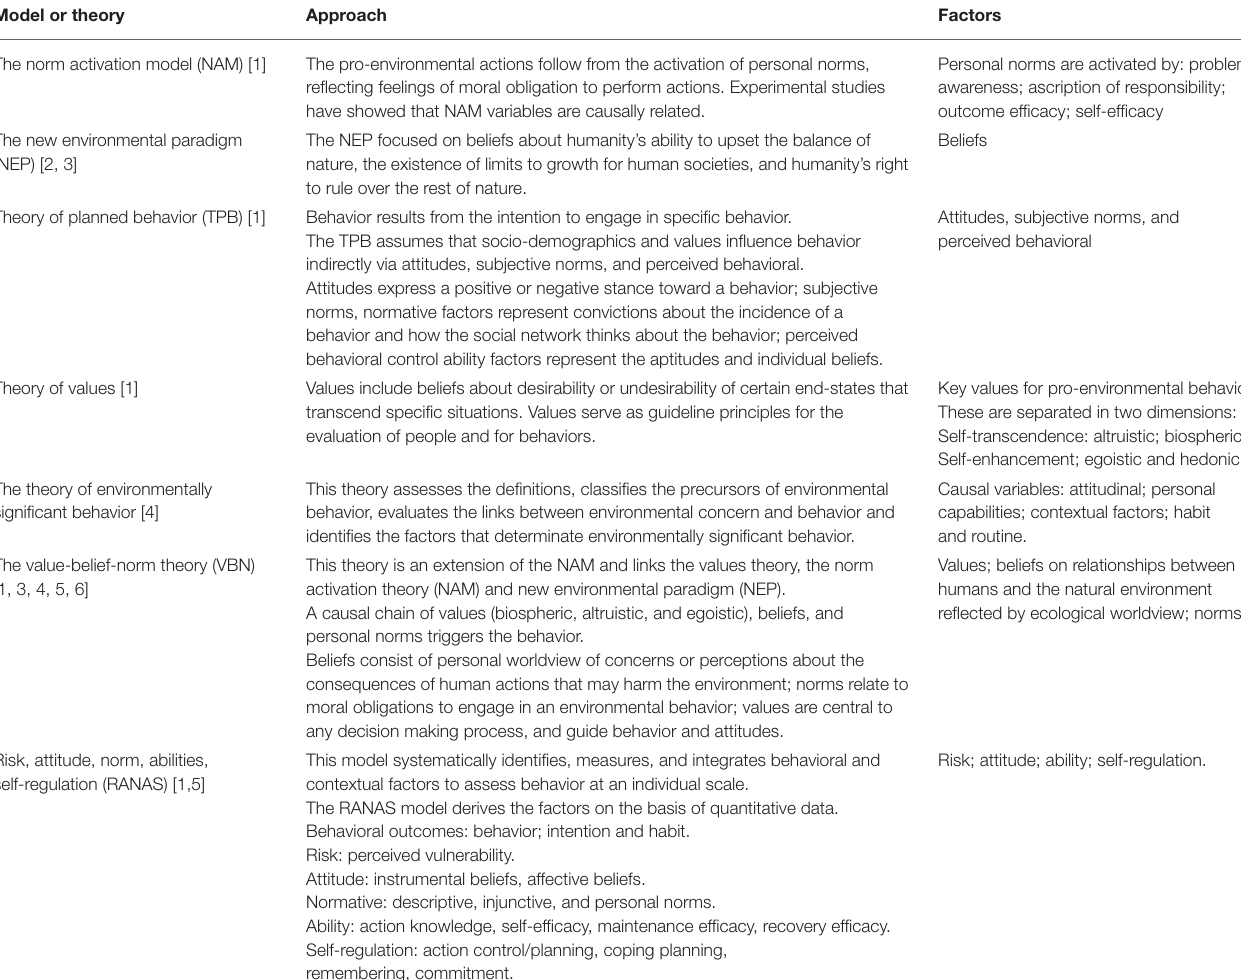
TABLE 5 | Models and theories and factors to understand environmental behavior.